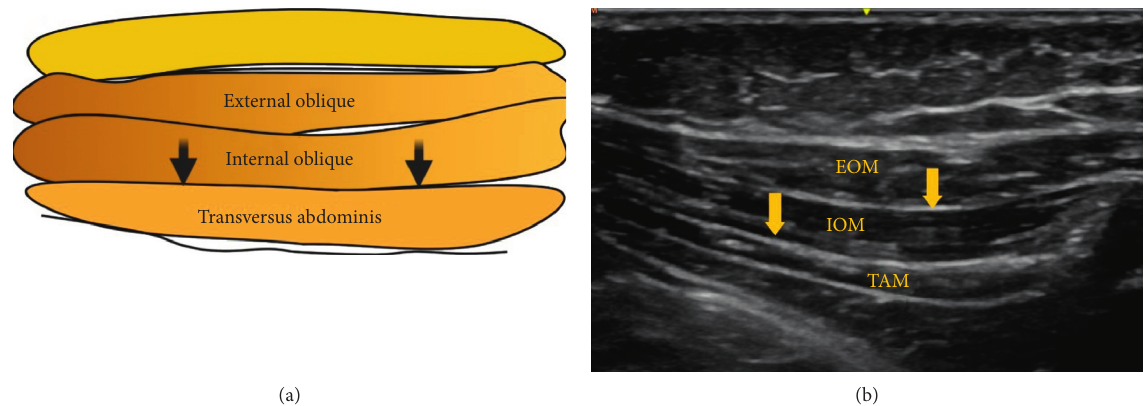
Figure 4: EOM: external oblique muscle; IOM: internal oblique muscle; TAM: transversus abdominis muscle. Black and yellow arrows indicate the point of local anesthetic infiltration.